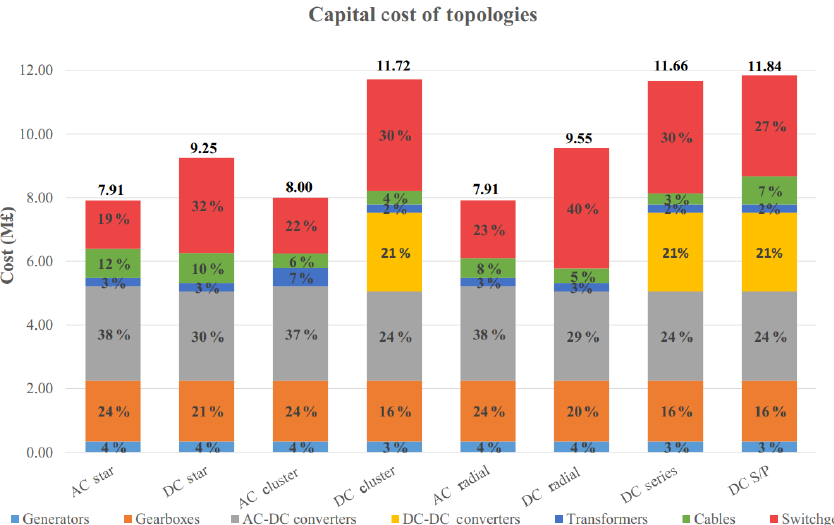
Figure 11. Total capital cost of electrical topologies with breakdown by component. Total capital cost is shown above each bar. Percentage of total capital cost is also shown for each component. Taking AC star as an example, the total capital cost is GBP7.91 million, with the generators accounting for 4% of the total cost, gearboxes accounting for 24% and so on.